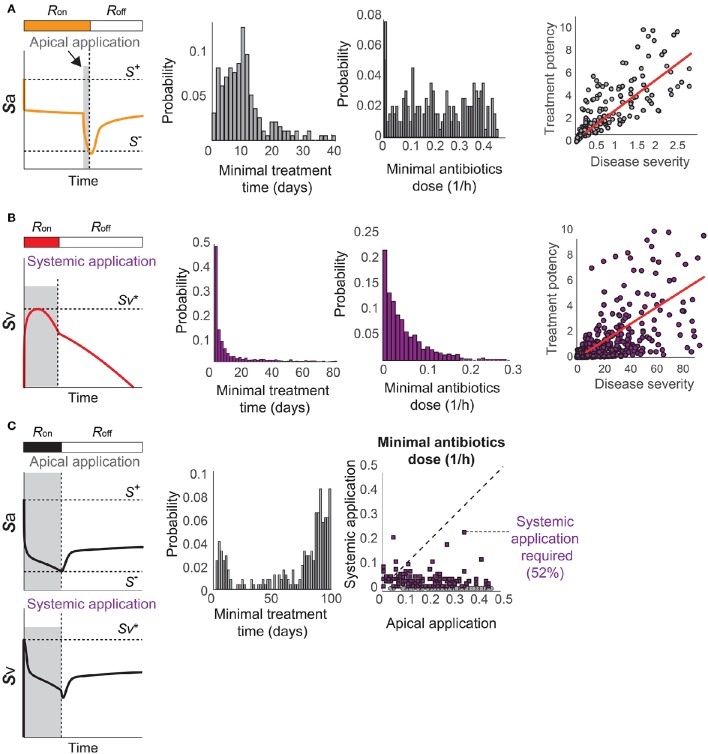
Optimal antibiotics treatment strategies for patients with (A) Immunological scarring to turn off the R-switch, (B) sepsis, and (C) sepsis and immunological scarring. Gray shaded regions in the left column denote the minimal time of application of antibiotics in the apical side of the epithelium or in the blood vessel (systemic application).